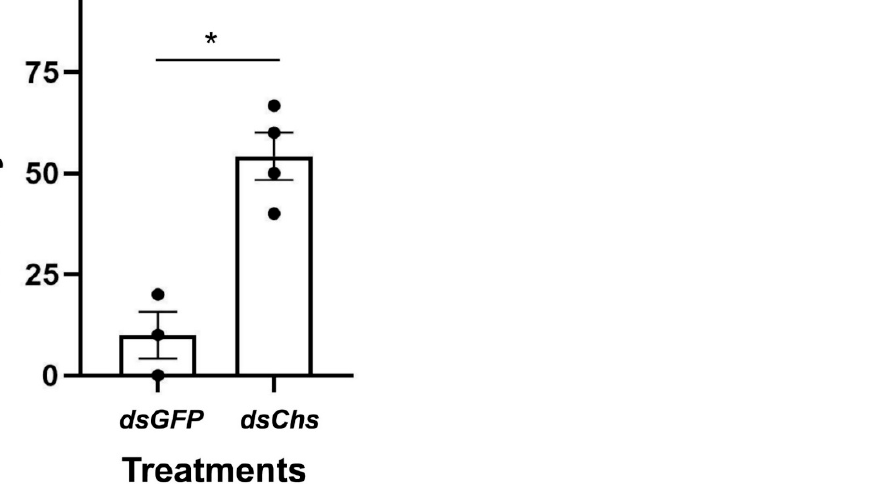
Figure 4. RNAi-mediated knockdown of CHS2 decreases L. trifolii survival. Percentage of mortality in insects immersed in dsCHS2 and dsGFP (control). The data are denoted as the mean ± the SE. Dots represent individual repetitions. Data were analyzed by Student’s t -test, p < 0.05. Asterisks represent significant dif f erences in mortality data.